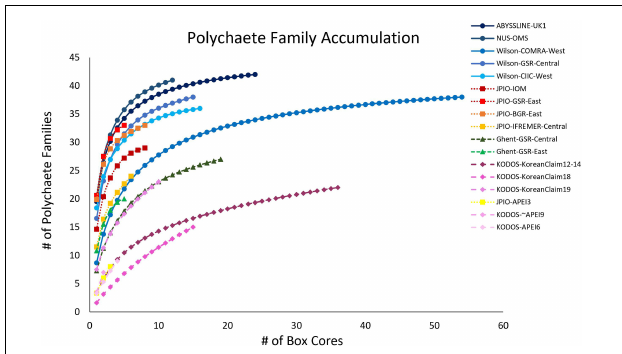
FIGURE 10 | Mean polychaete family accumulation versus number of box-core samples (UGE plot from EstimateS, 100 permutations) at different sites in the CCZ region. Note that KODOS data come from a single site sampled in different years. Data sets considered to have been sampled with similar protocols are indicated by similar